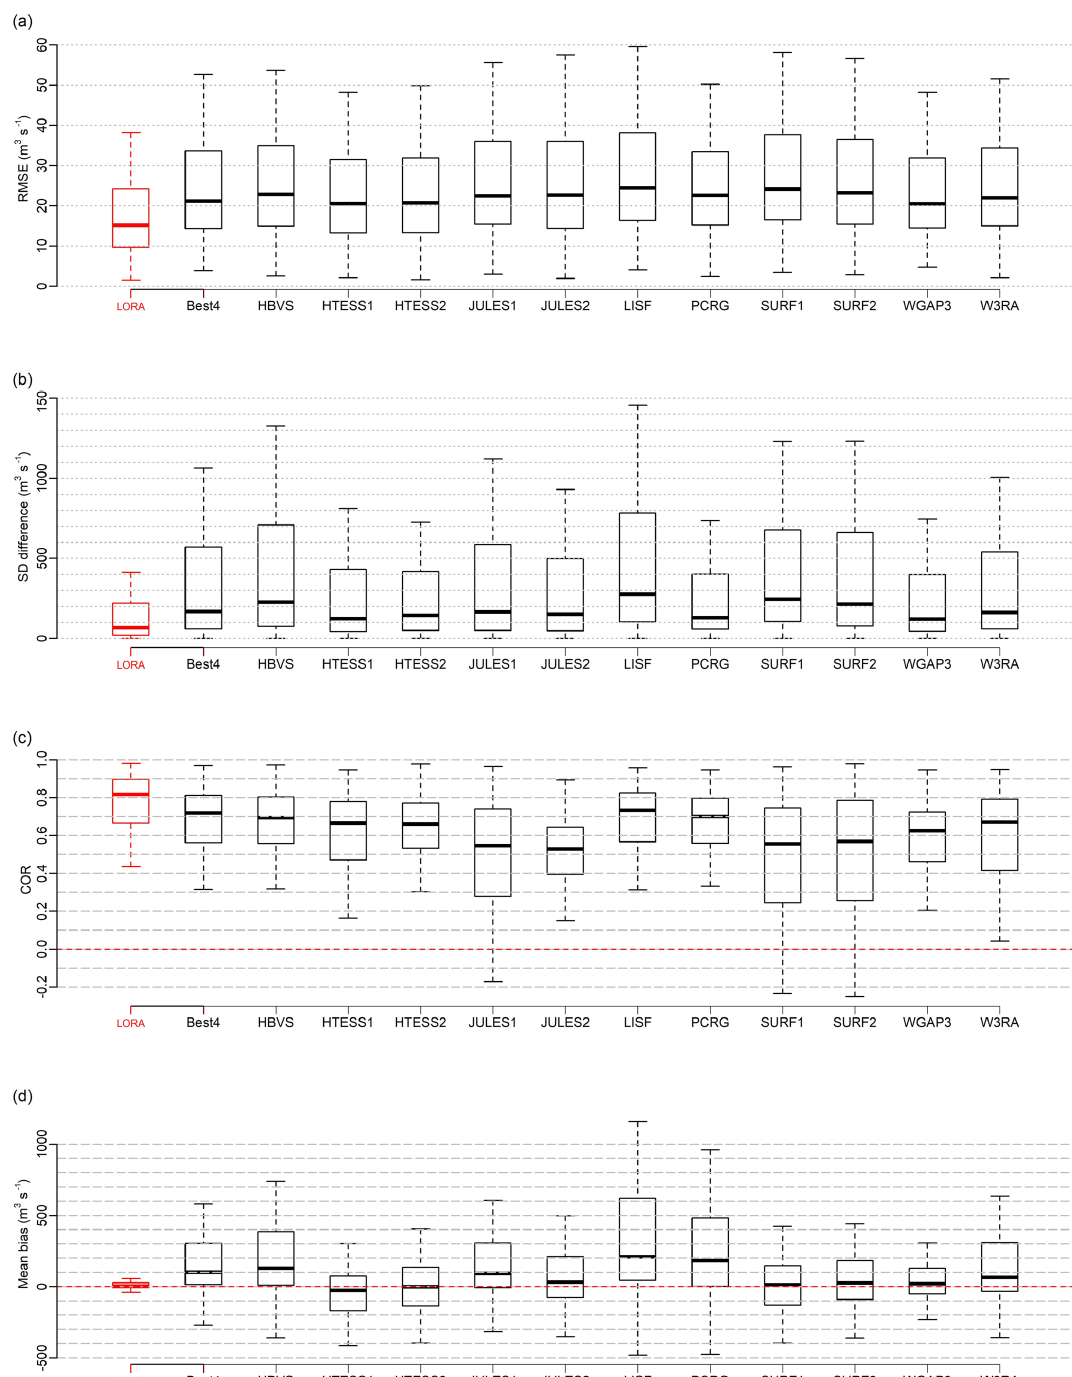
Figure 6. Four statistics, (a) RMSE, (b) SD difference, (c) COR and (d) mean bias, calculated for LORA, Best4 (i.e. the simple average of runoff estimates from LISFLOOD, WaterGAP3, W3RA and HBV-SIMREG) and each runoff product involved in this study at the gauged basins. See Table 1 for dataset